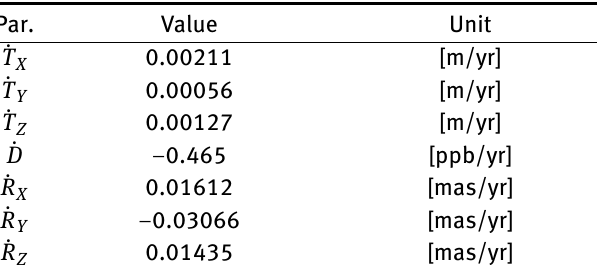
Table 3: Transformation parameters to estimate a correction to the velocities of the NKG RF 03 vel model in order to re-align the velocities to the